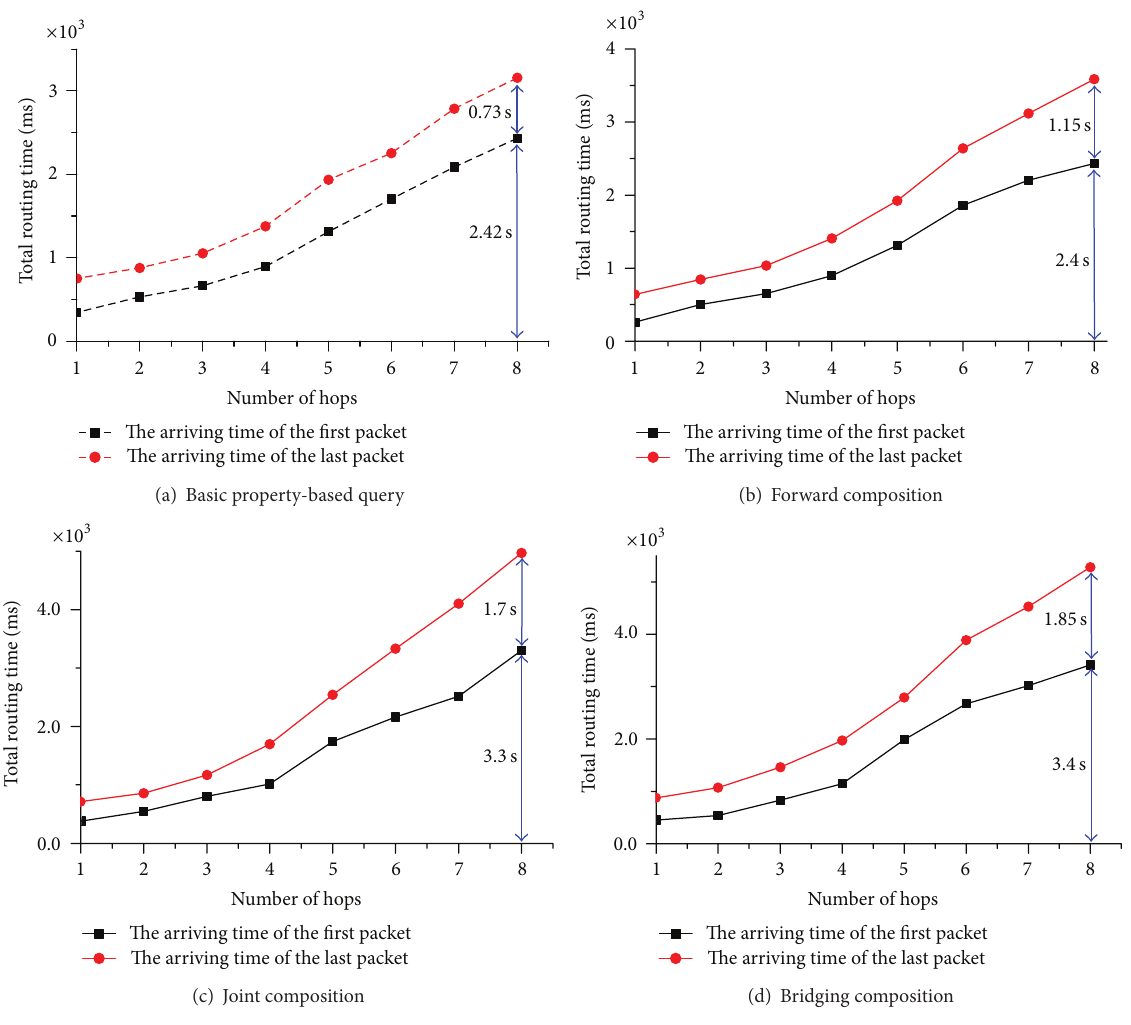
Figure 11: Testing results for total routing time with different hops (duplicates are 3).